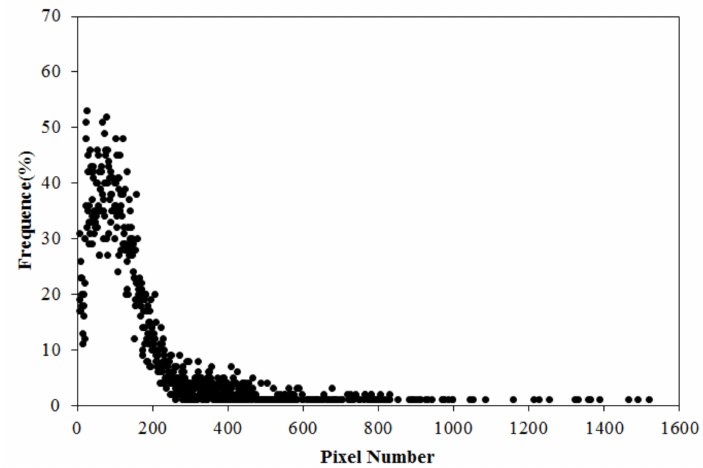
Figure 3. Frequency distribution chart of the cotton plant